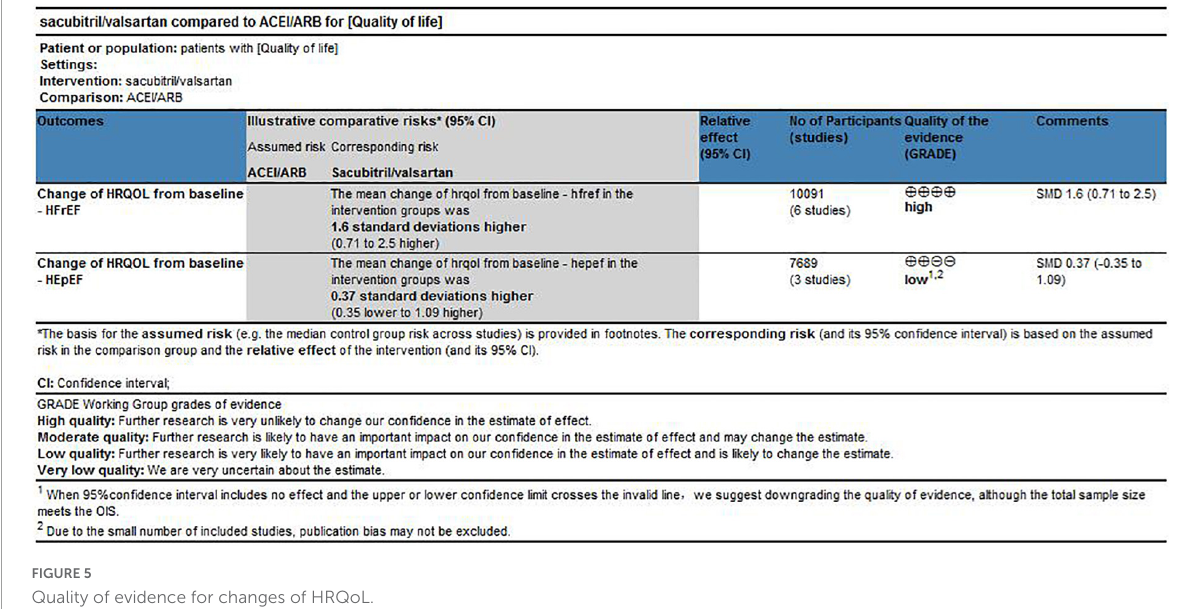
FIGURE5 Quality of evidence for changes of